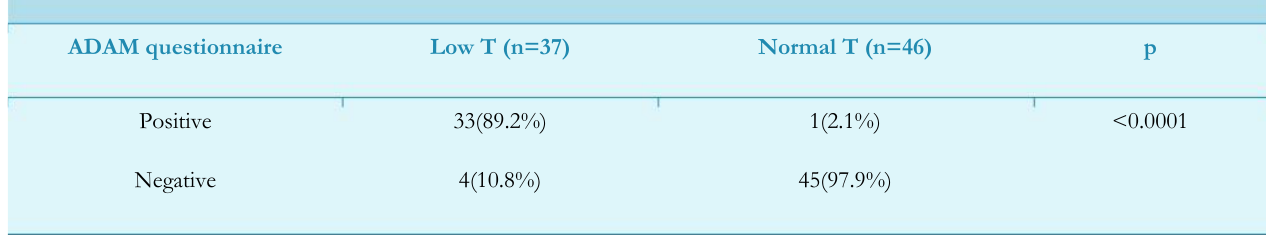
Table 4: Distribution of response to ADAM questionnaire among patients in the study group patients ADAM questionnaire